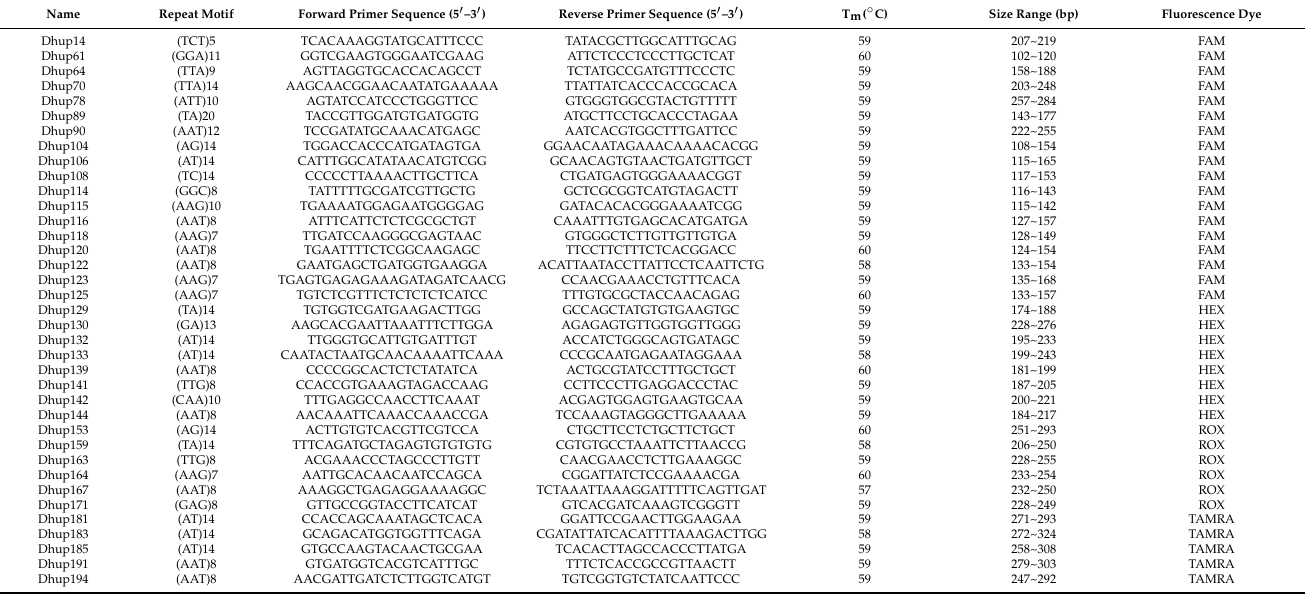
Table 2. Characteristics of 37 gSSR markers designed for D. hupeana in this